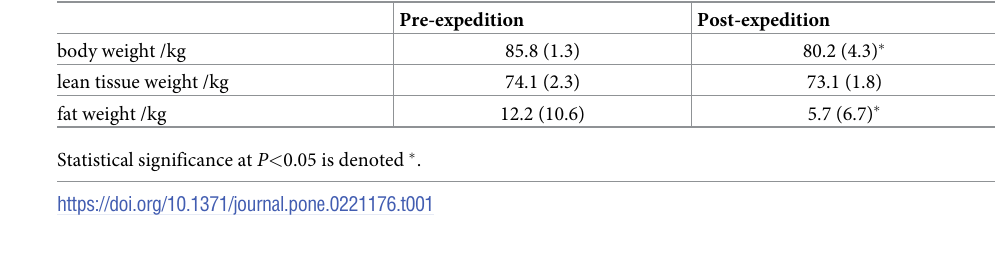
Table 1. The pre- and post-expedition values for body composition.